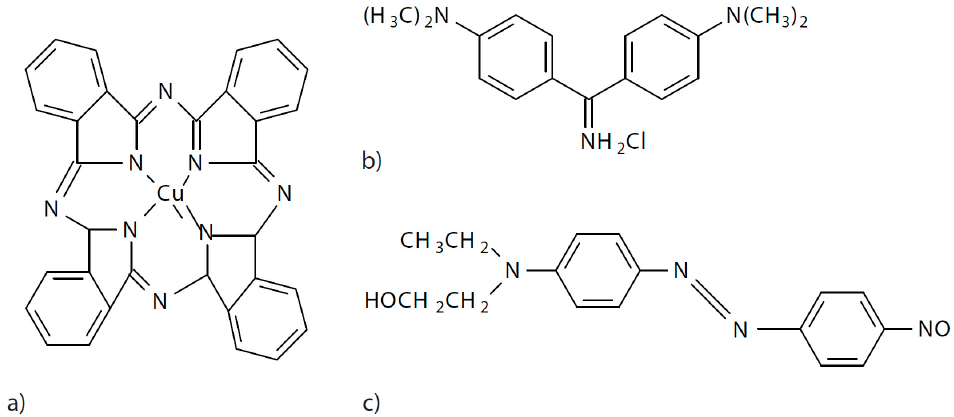
Figure 9. ( a ) Direct Blue 199, ( b ) Basic Yellow 2, ( c ) Disperse Red 1. Hydrotalcite Mg 6 Al 2 (CO 3 )(OH) 16 ·4(H 2 O) [66–68] of Sigma Aldrich Gillingham (U.K),